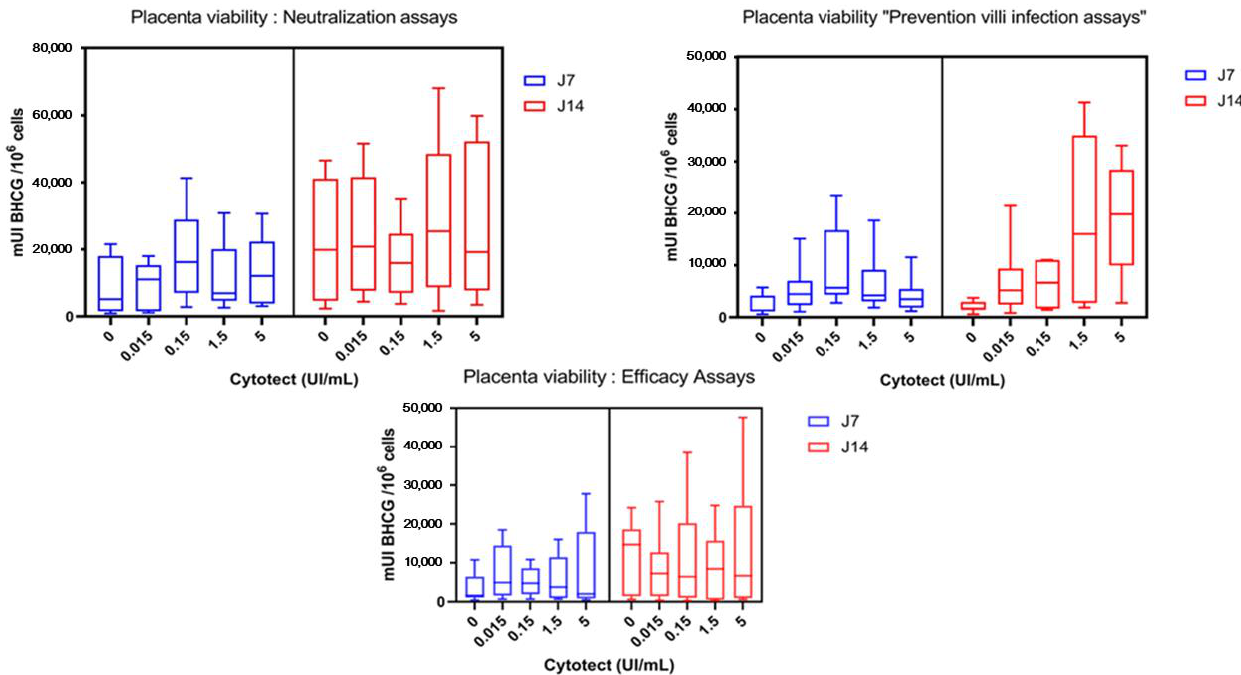
Figure 7. Placenta viability at 7 and 14 days post-infection for the “neutralization” and “prevention” assays and at 14 and 21 days post-infection for the “efficacy” assay. β -hCG units are indicated per 10 6 cells for each concentration. In this figure, “0” corresponds to the infected villi without Cytotect CP ® (positive control). The boxplots are designed as medians (Q2), lower quartiles (Q1), and upper quartiles (Q3) from three placentae. The whiskers are extended to the extreme data points. No significant difference was found between concentrations.